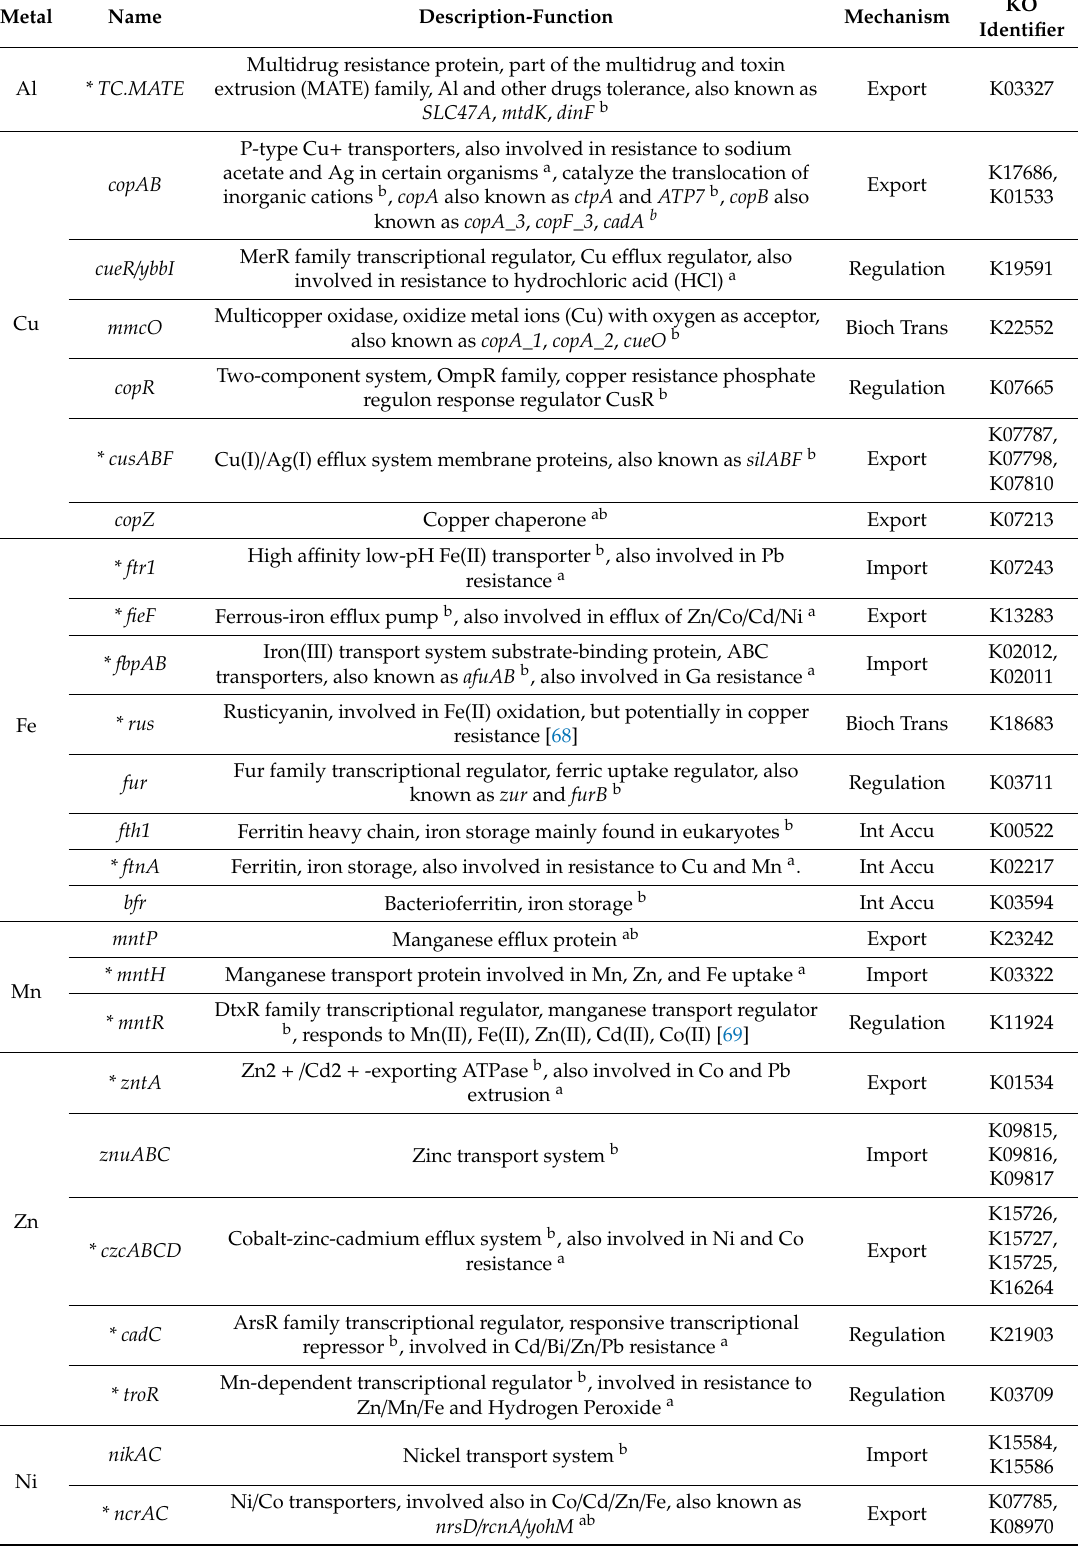
Table 3. Description of key metal resistance genes examined in Cueva de la Mora